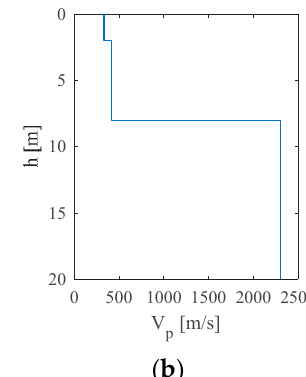
Figure 7. Dynamic properties of the soil along the depth: ( a ) S-wave velocity profile; ( b ) P-wave velocity profile.